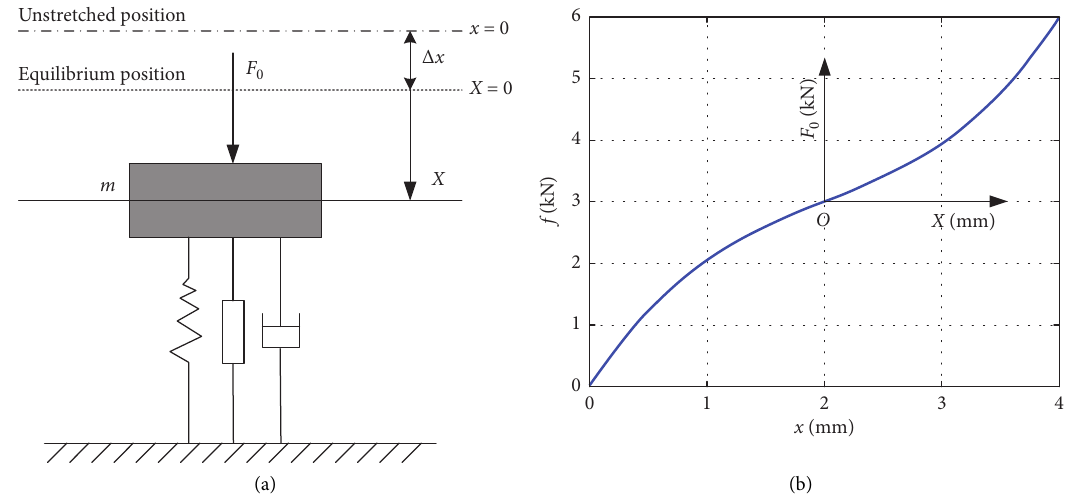
Figure 2: A single DOF nonlinear VIS: (a) system model and (b) load-displacement